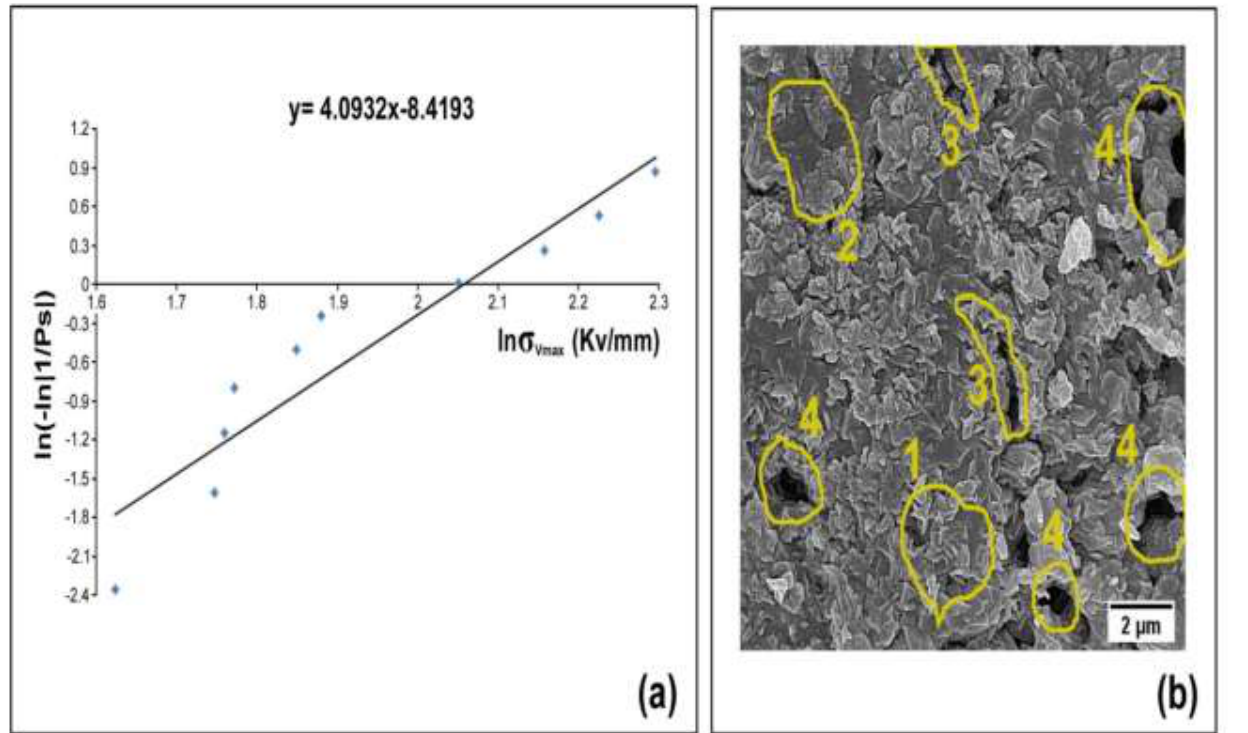
Figure 1: (a) Weibull modulus determination for LSGC as homogeneity indicator. (b) FESEM image for LSGC microstructure 2